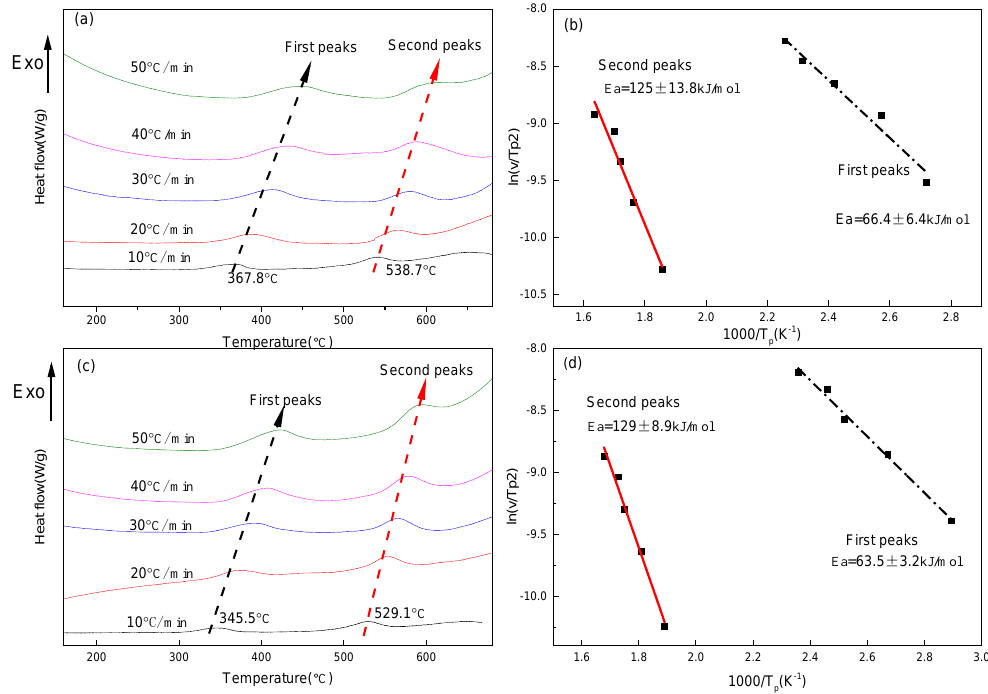
Figure 1. Differential scanning calorimetry (DSC) heating curves of as-solid-solution ( a ) Fe-free alloy and ( c ) Fe-doping alloy. ( b ) and ( d ) show Kissinger plots for the activation energies of the reactions, from the first temperature peaks and the second temperature peaks.